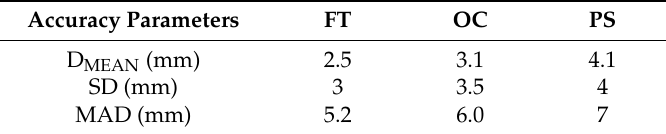
Figure 4. HCI glove with reflective markers on the finger tips. Table 1. Accuracy of the HCI for FT, OC and PS movements.